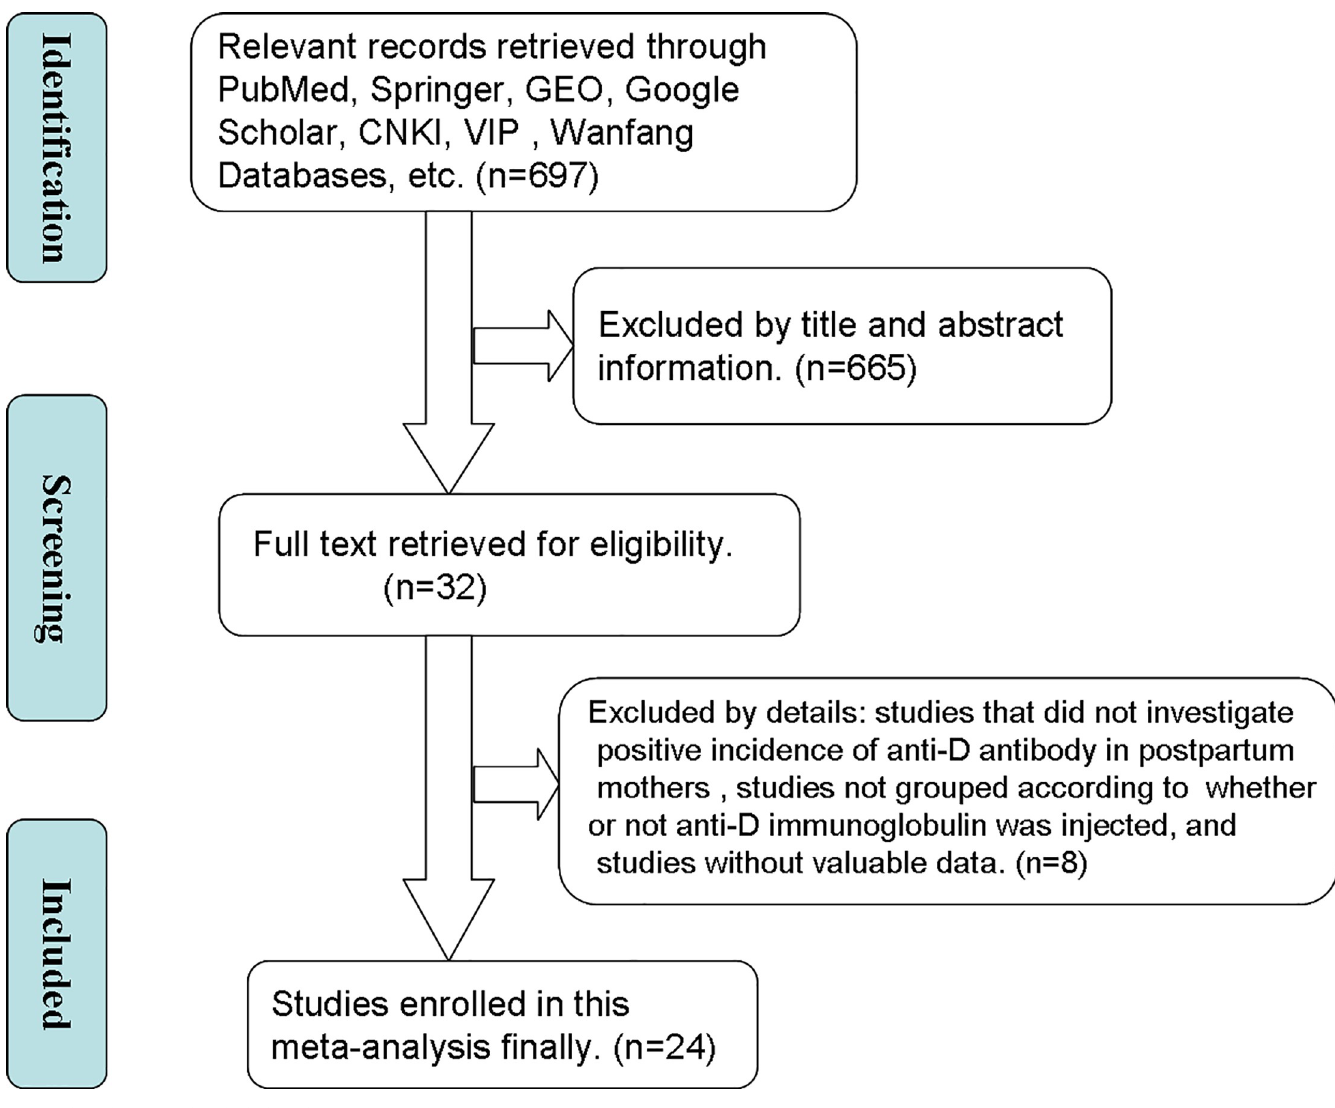
Fig 1. Flow diagram of included